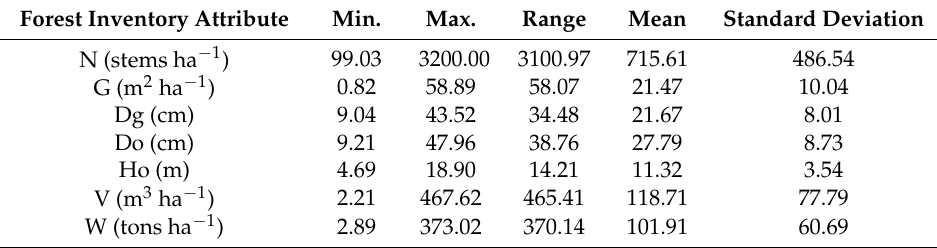
Table 3. Summary of the field plot characteristics ( n = 147). Forest Inventory Attribute Min. Max.